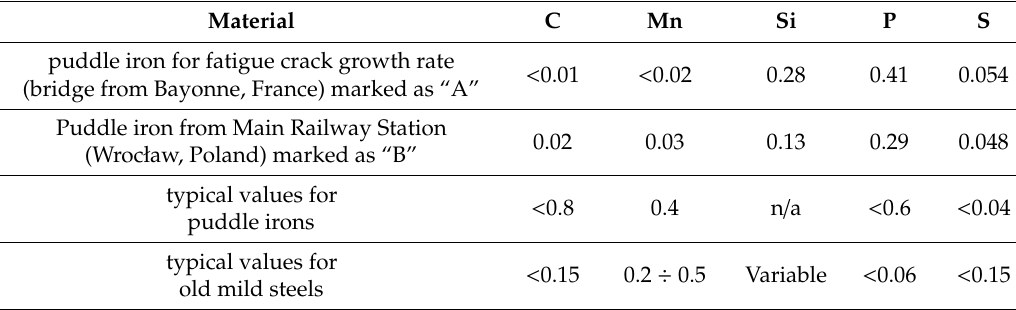
Table 1. Chemical composition (% by weight) of the tested material compared with typical puddle irons and old mild steels.